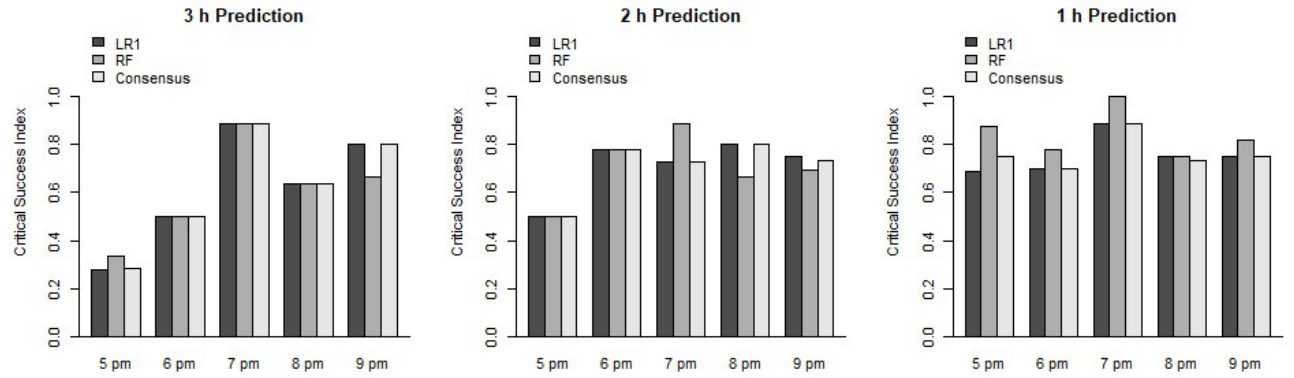
Figure 3. CSI of LR1, RF, and the consensus prediction; CSI = TP/(TP + FP + FN).